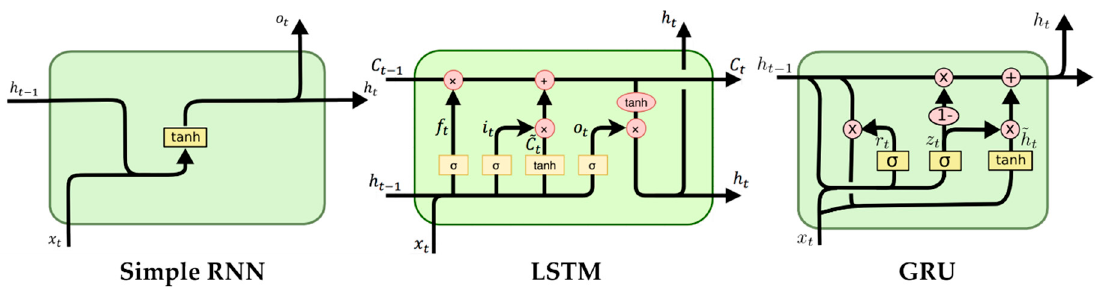
Figure 8. Comparison of RNN vs. LSTM vs. GRU units [41].